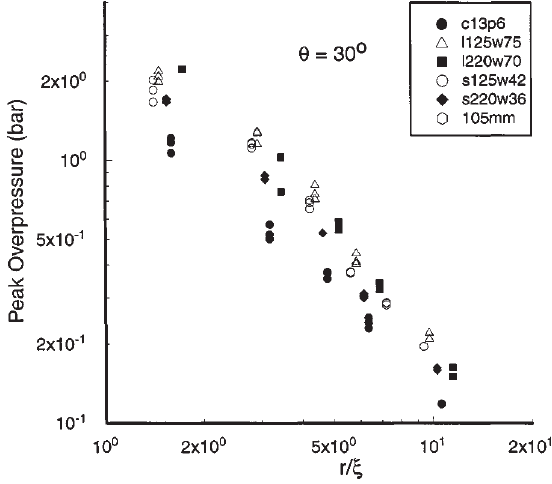
Fig. 2. Scaled peak overpressure data for θ = 30 ◦ (energy efflux